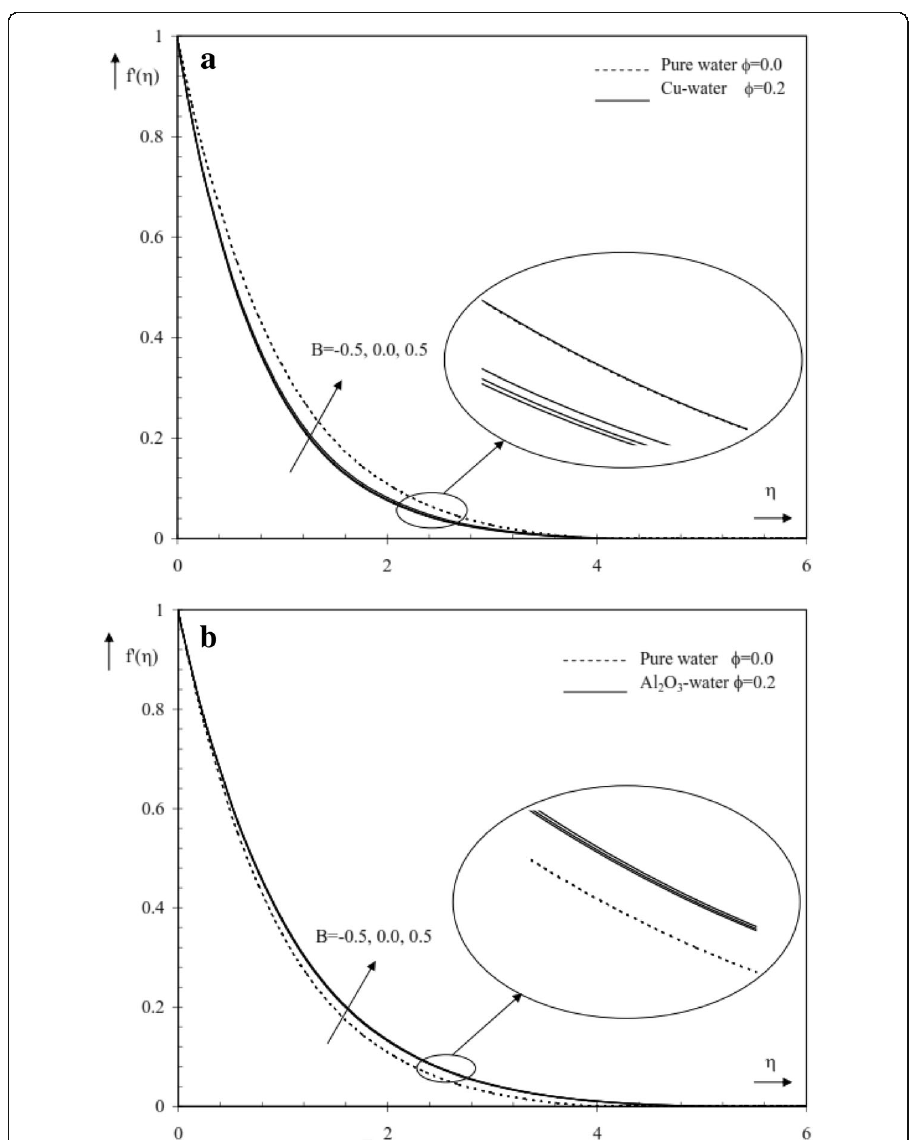
Fig. 11 Effects of ϕ and B on velocity distribution f ′ ( η ) for S = M = f w = 0.1 and A = λ = 0.5 for a Cu-water and b Al 2 O 3